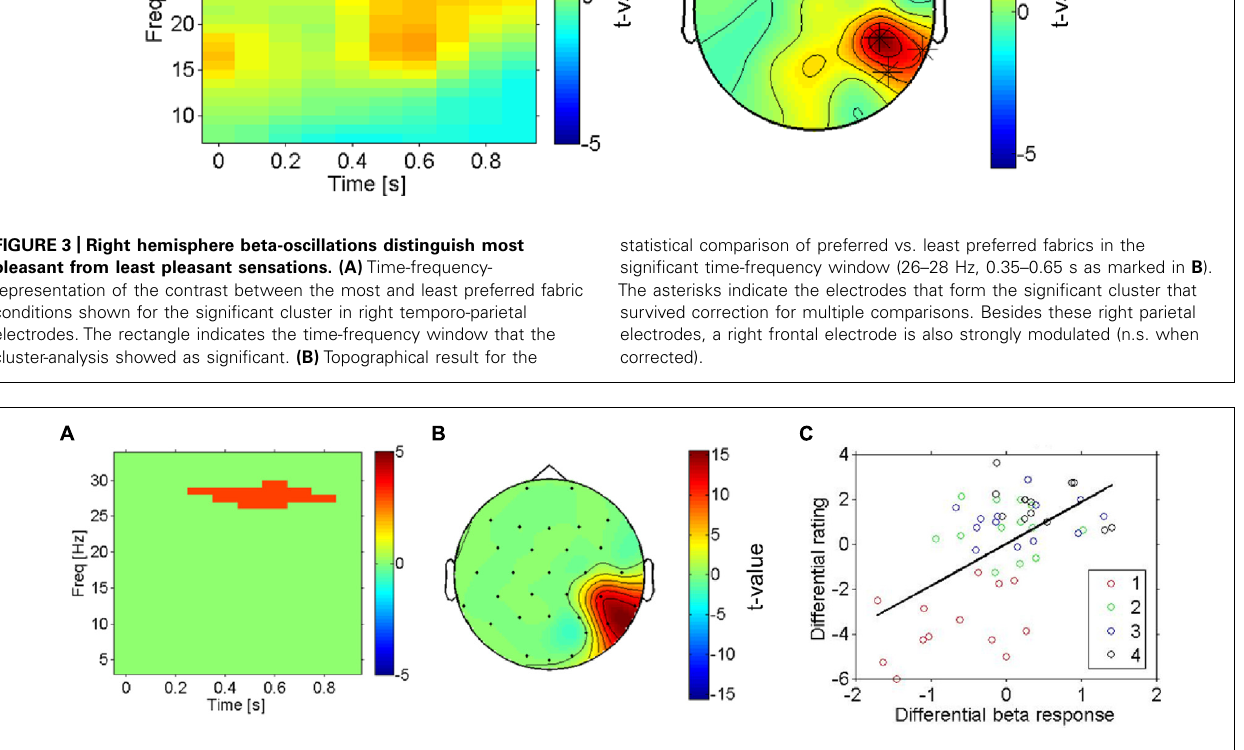
(C) Scatterplot of induced beta-oscillations in right temporo-parietal electrodes (see A ) against likeability ratings of each fabric (in different colors). The mean across conditions was subtracted from each subject (both EEG and ratings) to reveal differences between conditions rather than inter-individual differences of their averages across conditions.There is a strong positive correlation between the beta-response and the likeability ratings, indicating that the effect shown in (A,B) does not reflect a mere physical difference in